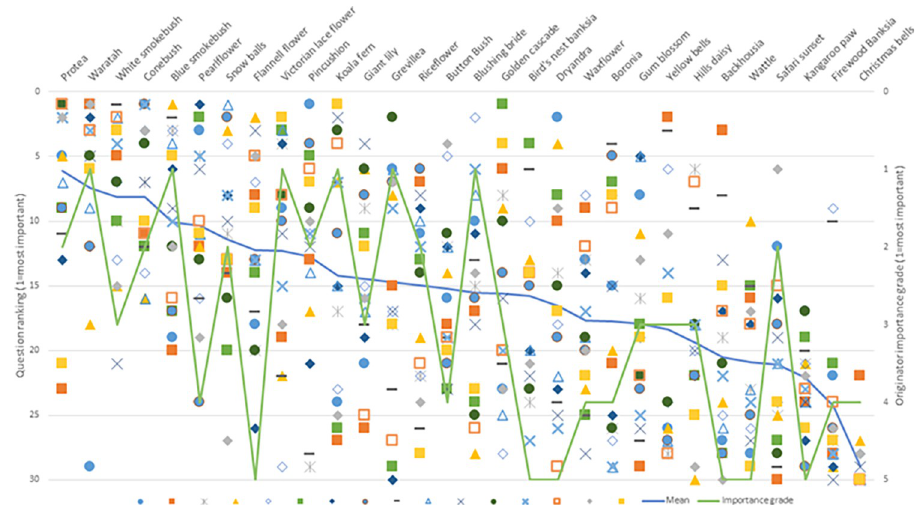
Fig 2. Distribution of rankings and importance grade of 30 research questions relevant to MSK clinical trials. Each research question is labelled as an Australian wildflower and are displayed in order of most highly ranked to least highly ranked. The blue line shows the mean ranking (left axis) and the green line shows the importance grade nominated by the source of the research question (right axis). Each data symbol represents a workshop participant.